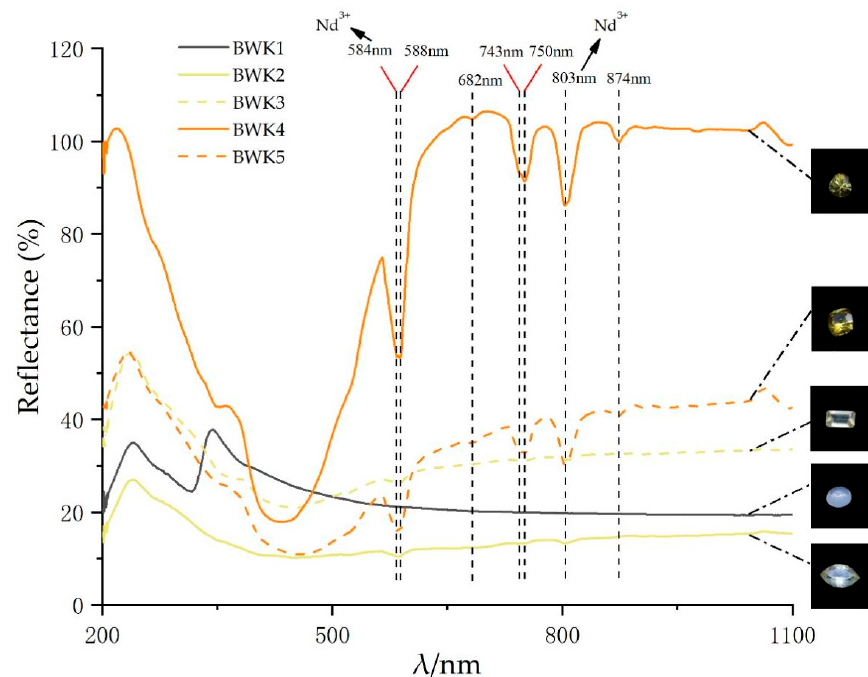
Figure 7. UV-Vis spectra of scheelite samples